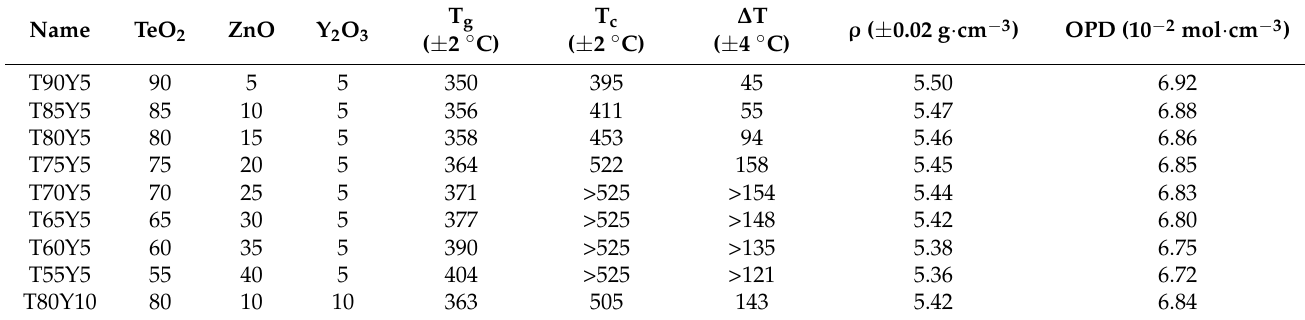
Figure 3. DSC thermographs of ( a ) the T85Y5, T90Y5 and T95Y5 samples; ( b ) the T75Y5, T80Y10 and T80Y5 samples and ( c ) the T55Y5, T60Y5, T65Y5 and T70Y5 samples. ( d ) Compositional depen- dence of glass transition temperature T g and onset crystallization temperature T c in the glass series (100 − x) TeO 2 -x ZnO-5 Y 2 O 3 (with x = 0, 5, 10, 15, 20, 25, 30, 35, 40). Table 1. Physico-chemical properties of glass forming compositions in the TeO 2 -ZnO-Y 2 O 3 ternary system. Glass transition temperature (T g ), onset crystallization temperature (T c ), thermal stability ∆ T = T c − T g , density ρ and oxygen packing density